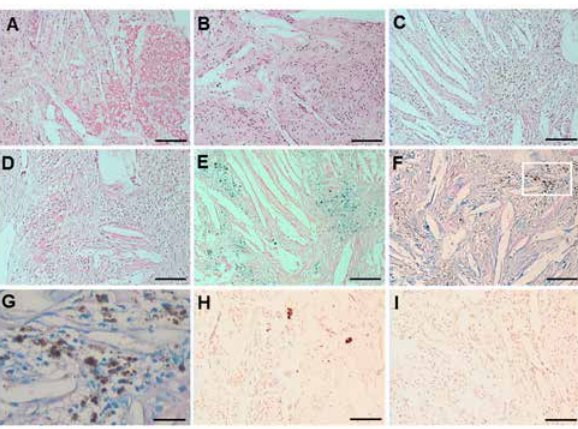
Figure 2: Photomicrographs of the surgical specimens from this case. Haematoxylin-Eosin (H & E) stained frozen section (A)